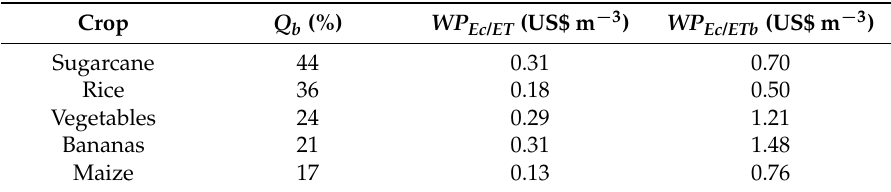
Table 9. Economic water productivity for the main irrigated crops expressed in terms of net irrigation water use, for the period of